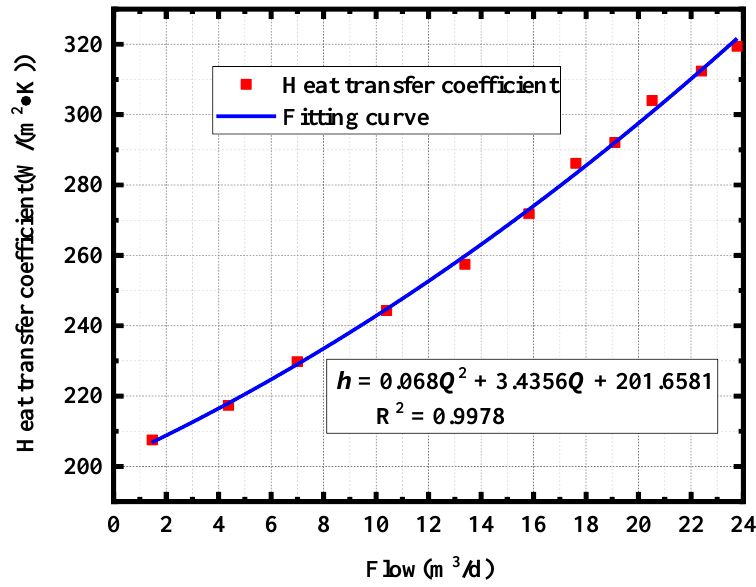
Figure 8. Diagram of heat transfer coefficient and flow rate.